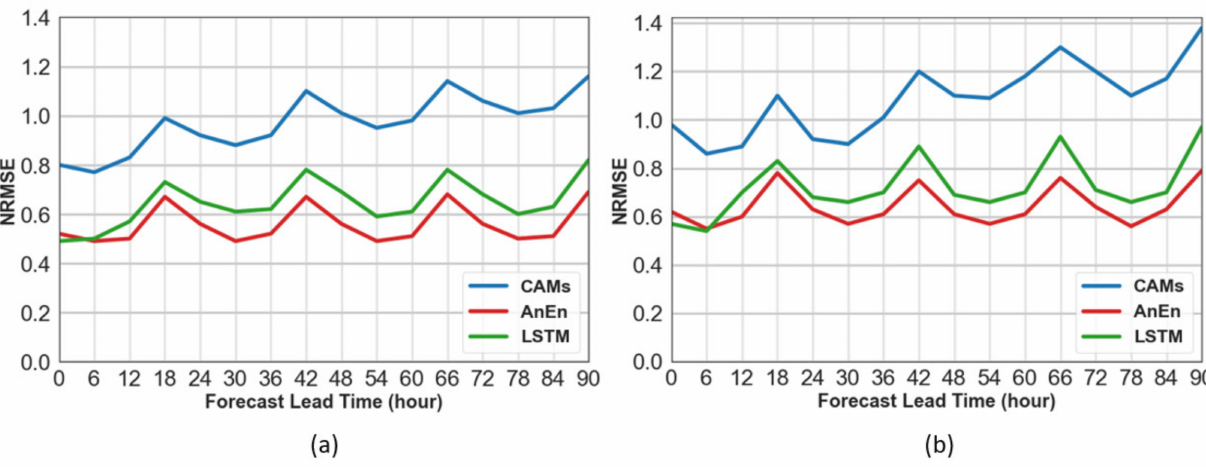
Figure 7. Normalized RMSE of the prediction methods of ( a ) PM 2.5 and ( b ) PM 10 as a function of the forecast horizon for the test period aggregated at the eight air monitoring